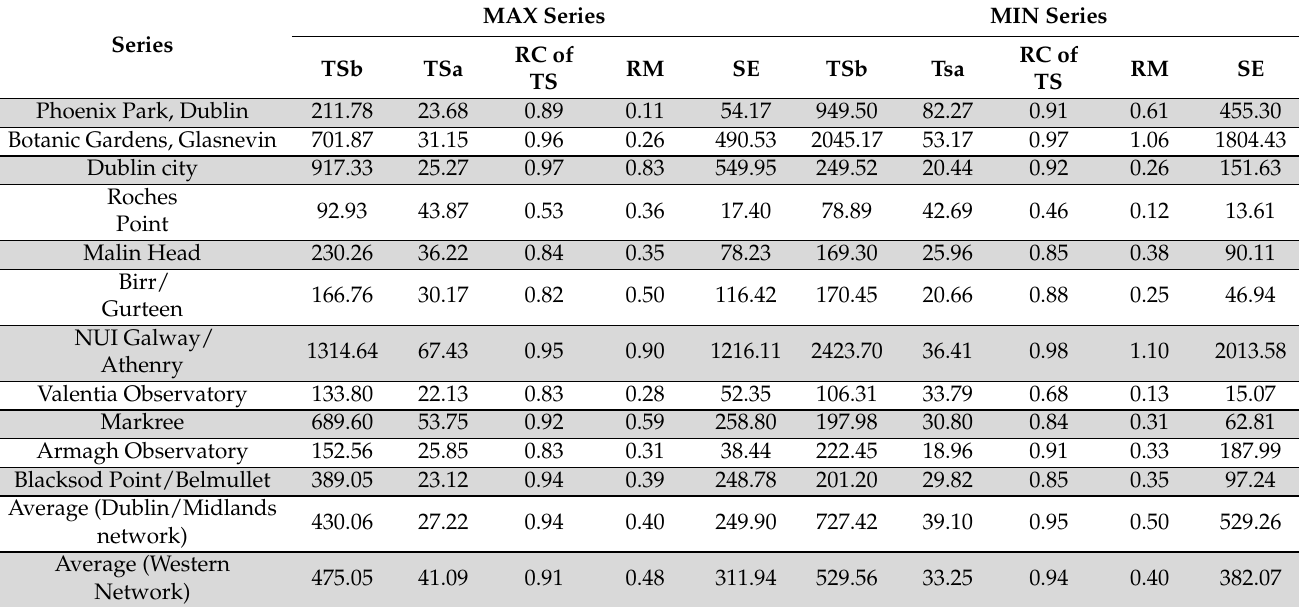
Table 8. Average test statistics for series included in the Dublin/Midlands and Western networks. Critical value (significance level 0.05): 21.94. TSb—test statistics before homogenisation; TSa—test statistics after homogenisation; RC of TS—relative change of TS; RM—relative modification; SE—statistics for estimated inhomogeneities.